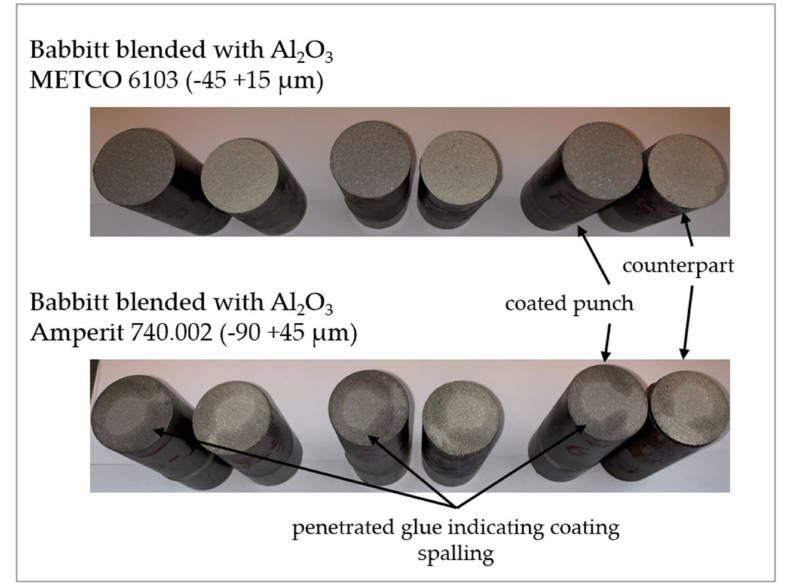
Figure 7. Coated punches and counterparts after the applied adhesion